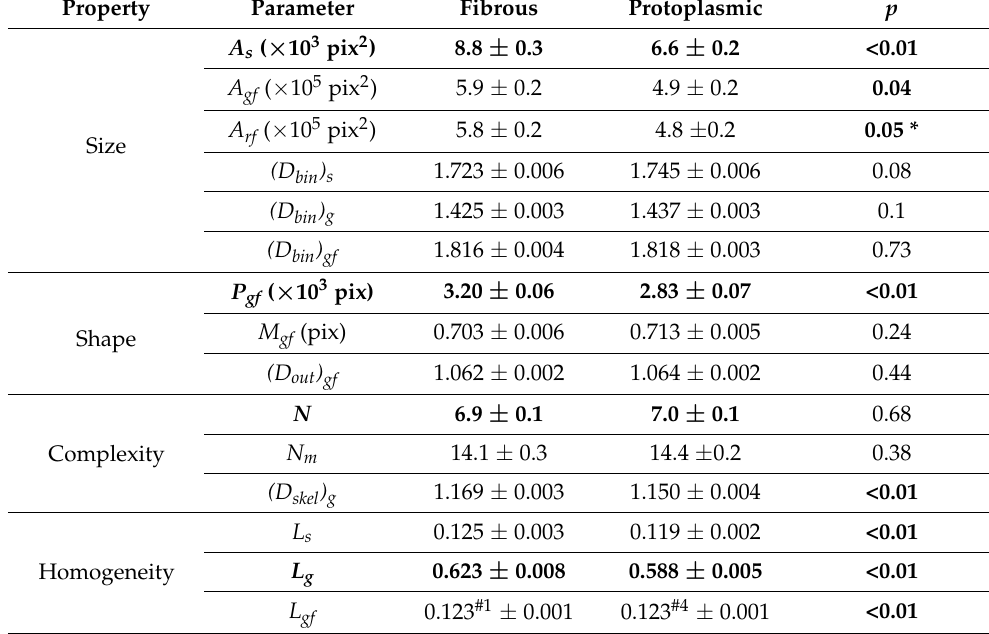
Table 2. The mean values and standard errors of fifteen parameters of the size ( A s , A gf , A rf , ( D bin ) s , ( D bin ) g and ( D bin ) gf ), the shape ( P gf , M gf and ( D out ) gf ), the complexity ( N , N m and ( D skel ) g ) and the homogeneity ( L s , L g and L gf ) of two types of astrocytes. The comparison of means between two independent samples was presented with the p value, while statistical significance was bolded. Property Parameter Fibrous Protoplasmic p A s ( × 10 3 pix 2 ) Size